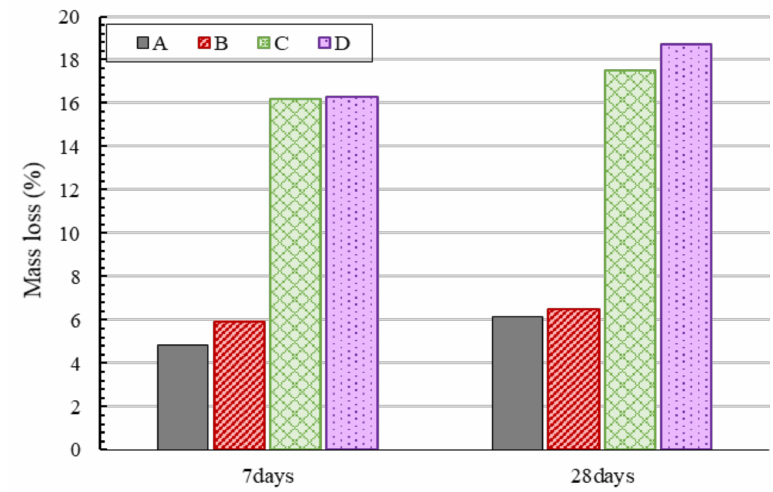
Figure 7. Mass loss (%) of CaCO 3 calculated from TG curves in paste specimens after 7 and 28 days of